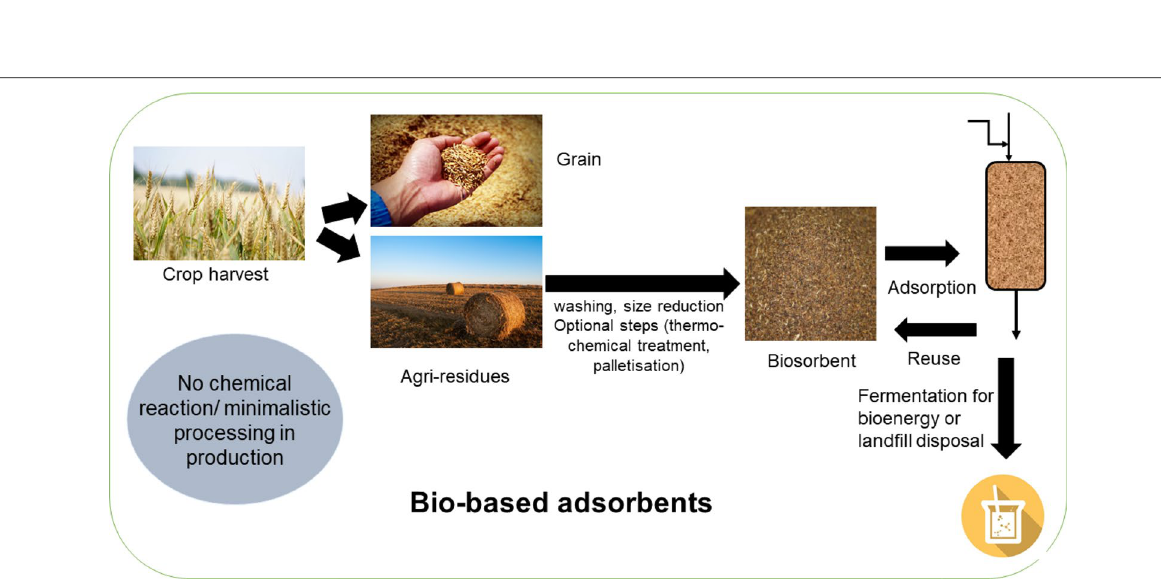
Fig. 3 Schematic of generation, use, and disposal of